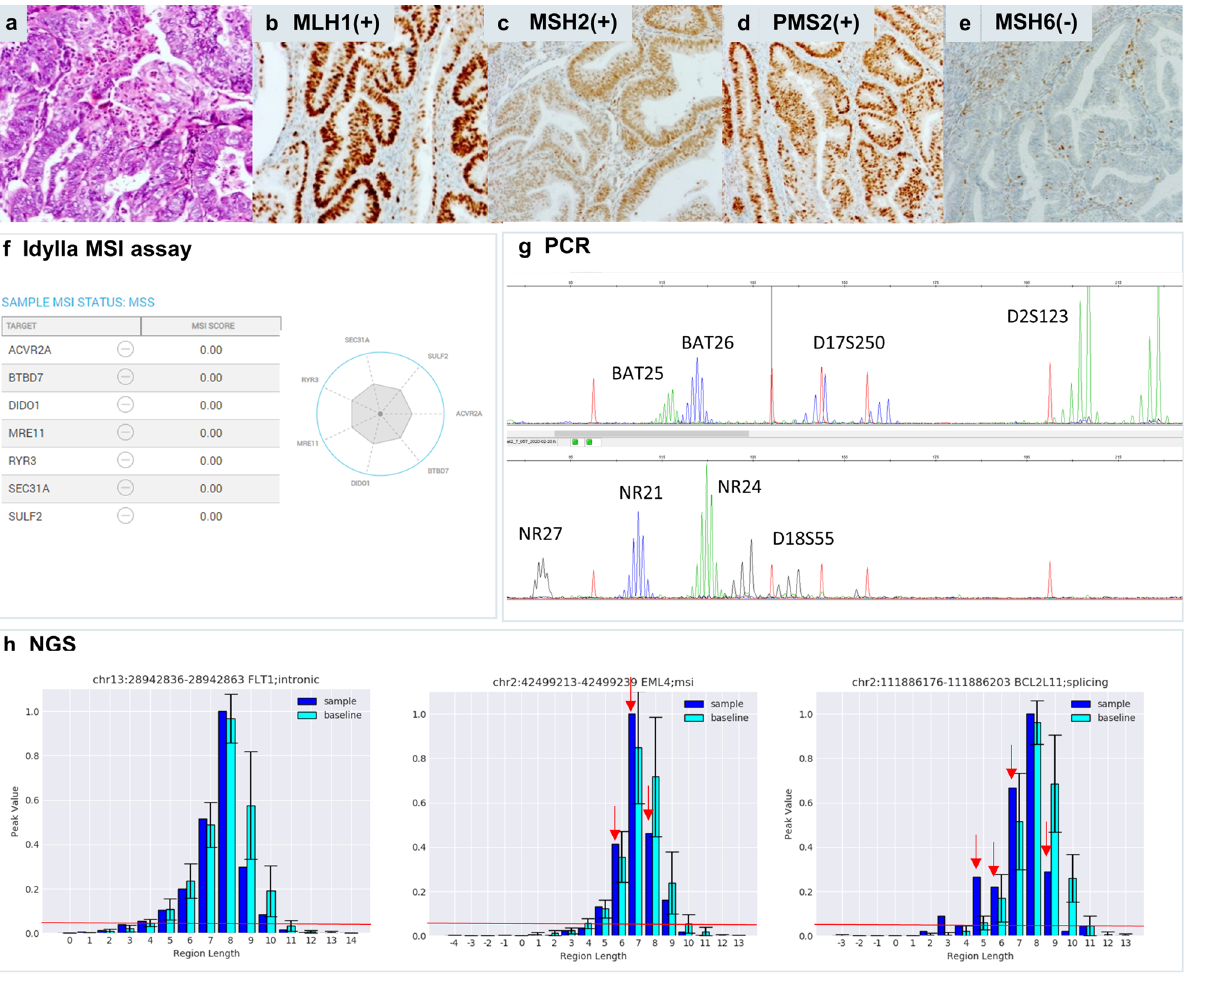
Figure 6. Endometrial dMMR/MSI tumor (case 45) with isolated loss of MSH6 expression, falsely negative by Idylla MSI assay, PCR and NGS. Hematoxylin eosin stain ( a ) of the tumor with classic morphology of endometrial adenocarcinoma (UCEC) with isolated loss of nuclear MSH6 ( e ) and preserved nuclear expression of MLH1 ( b ), MSH2 ( c ) and PMS2 ( d ). Idylla MSI assay (Idylla Explore software v.2.5.1294) ( f ) and PCR (GeneMapper v. 4.0 analysis software, Applied Biosystems). ( g ) called respectively 0/7 loci and 0/8 loci as MSS, resulting in MSS integrative result (Fig. 2). NGS (Python v.3.7 and Matplotlib 3.3.4 software) called 2/10 loci as unstable (Fig. 2) resulting in an overall MSS/0 score. Illustrative indel distribution plot of the FLT1, EML4 and BCL2L11 loci ( h , from left to right) indicated identical number of integrated peaks (6/5/6 for respectively FLT1/ EML4/BCL2L11 loci) in tumor sample (dark blue bars) versus baseline (light blue bars) resulting in calling these loci as negative by the default mSINGS script. However, for the EML4 and BCL2L11 loci, the overall indel distribution did shift towards shorter indel lenghts as indicated by the red arrows, suggesting the presence of molecular alterations not recognized by the current parametrization of the